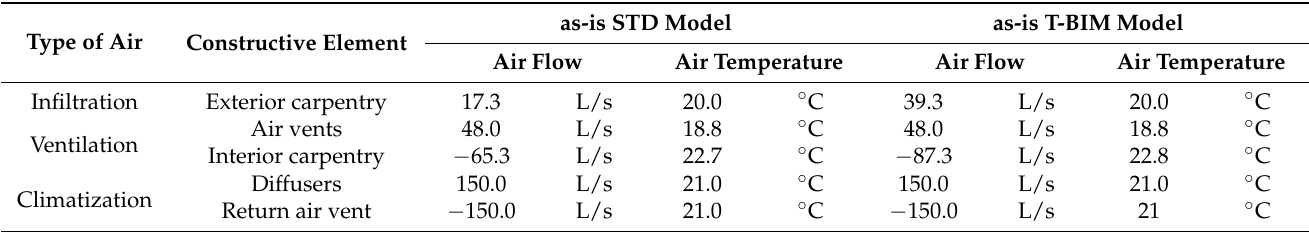
Table 8. Intake and outtake air flows of contour elements linked for the CFD trial simulation at 17 h on 19 November, in Room W1.